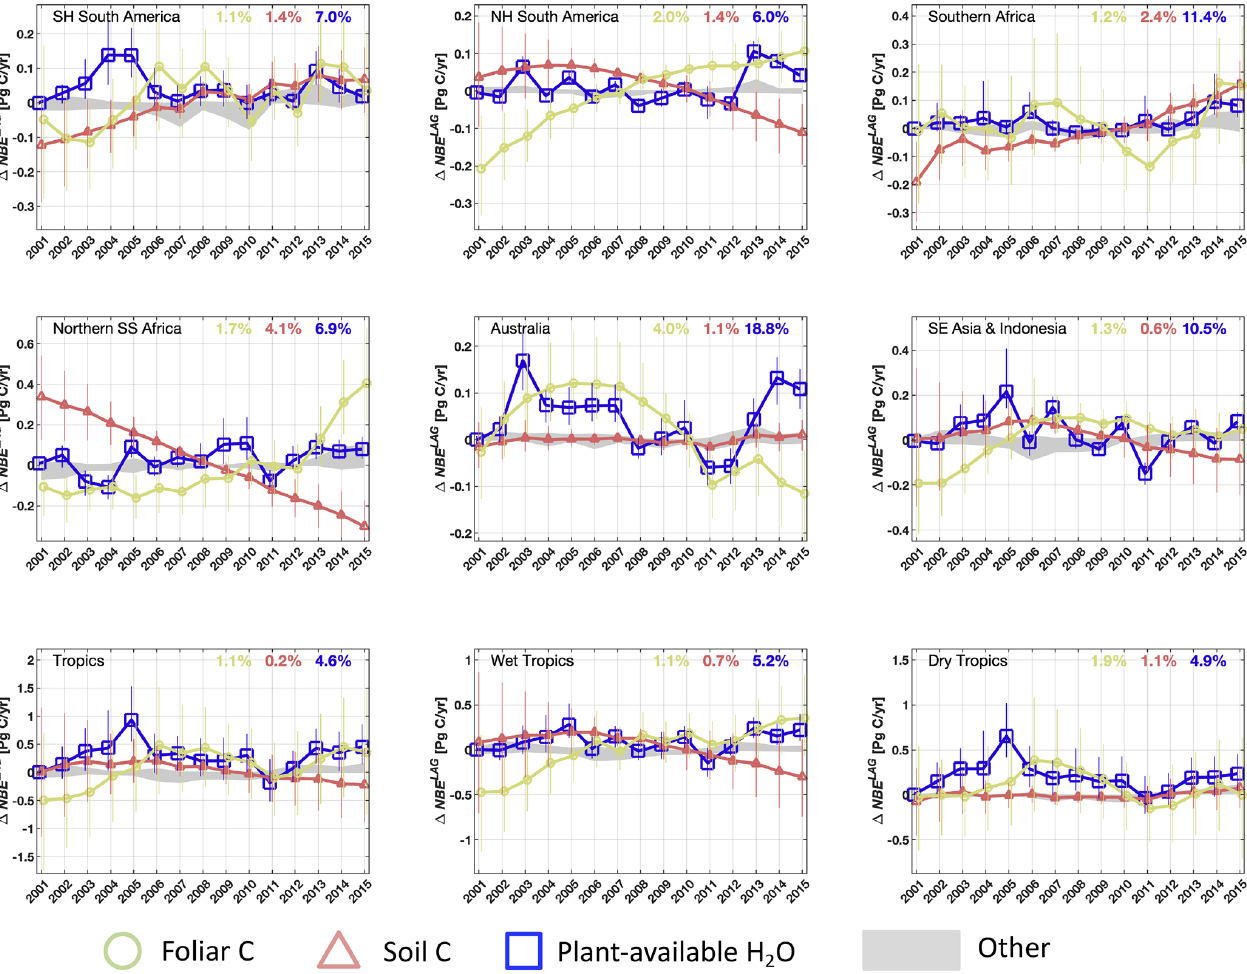
Figure 8. Attribution of 2001–2015 annual regional and pan-tropical NBE lagged effect estimates ( (cid:49) NBE LAG ) to individual ecosystem state anomalies (i.e. the lagged effect in year a solely attributable to anomaly in ecosystem state n , (cid:49) NBE LAG foliar C (green circles), soil C (dark pink triangles), and plant-available H 2 O (blue squares), the grey areas (labelled as “Other” in the figure legend) denote the collective range of (cid:49) NBE LAG anomalies attributable to labile, wood, root and litter C. Percentage values indicate the inter-annual variability (reported as standard deviation) of median foliar C, soil C and plant-available H 2 O states throughout the 2001–2015 period, relative to mean 2001–2015 values within each region. The sum of annual state-specific (cid:49) NBE LAG values is approximately equal to the (cid:49) NBE LAG (see Fig. S4). Error bars denote the 25th–75th percentile uncertainty estimates for each flux